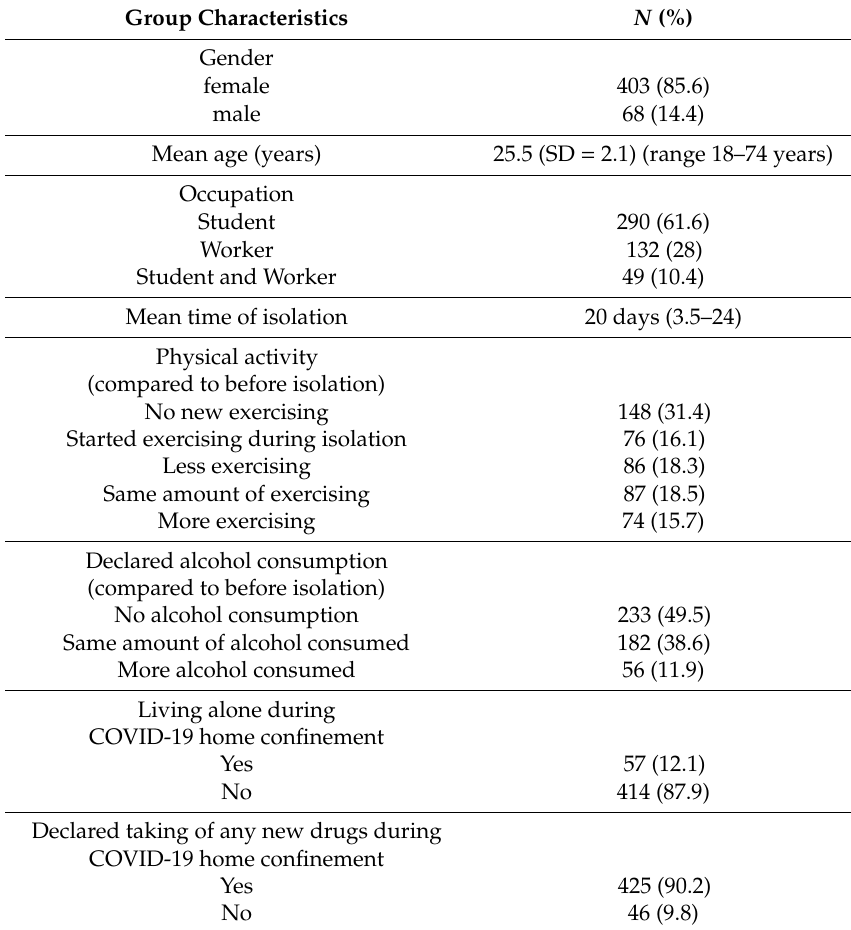
Table 1. Demographic and complementary data, n =